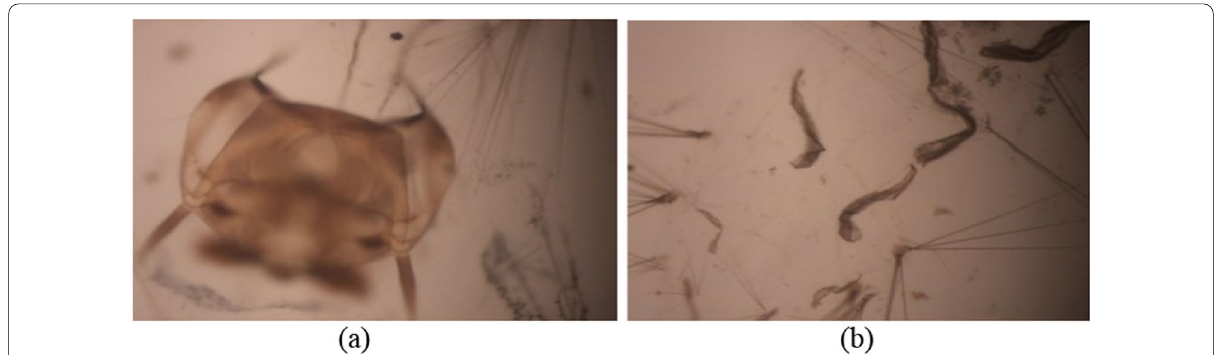
Fig. 9 Larvicidal activity of CuNPs (100 mg/ml) ( a , b